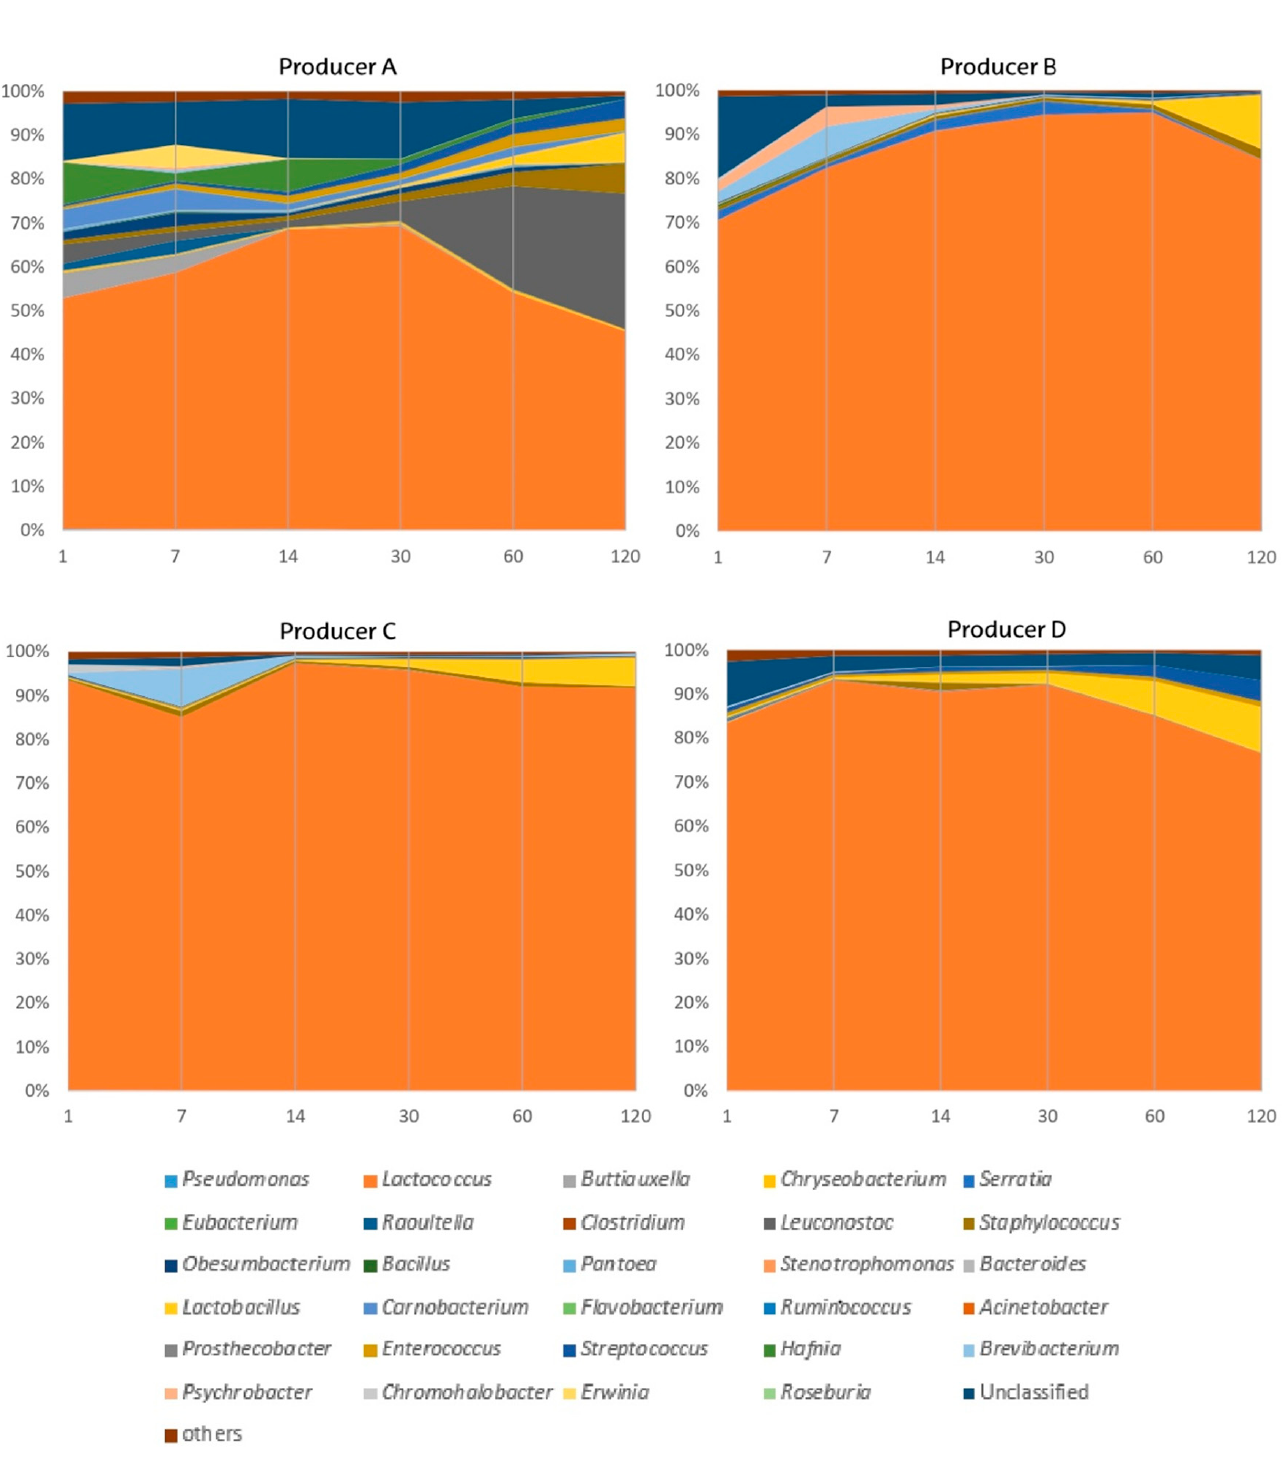
Figure 2. Microbial shifts at genus rank during ripening time (from 1 to 120 days) of Idiazabal cheese samples from different producers ( A – D ).